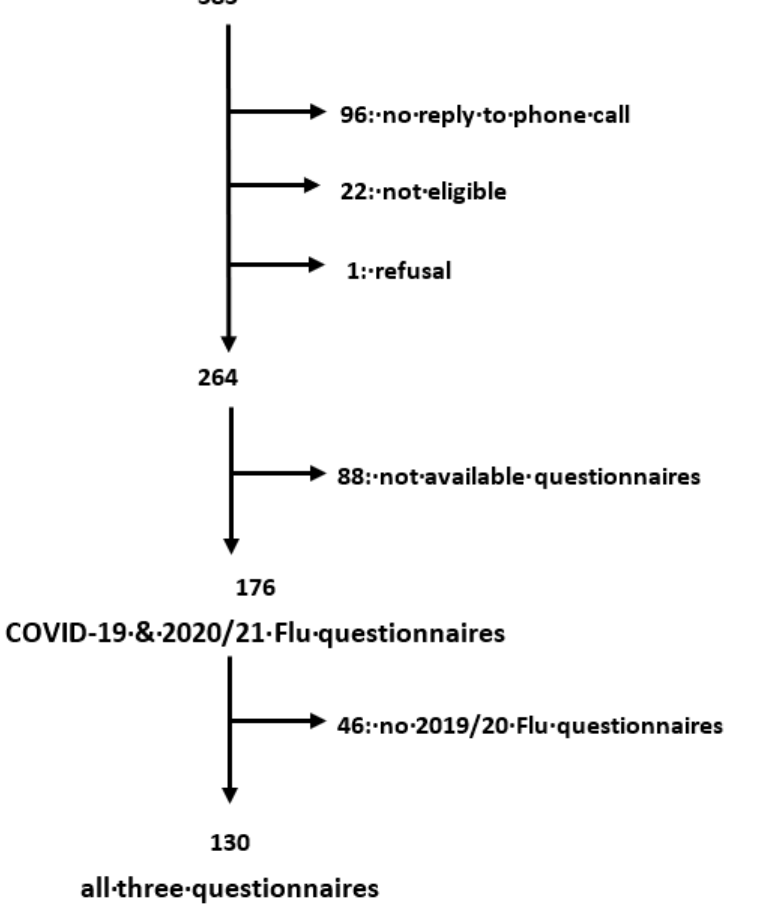
Figure 1. Selection process of the study population.